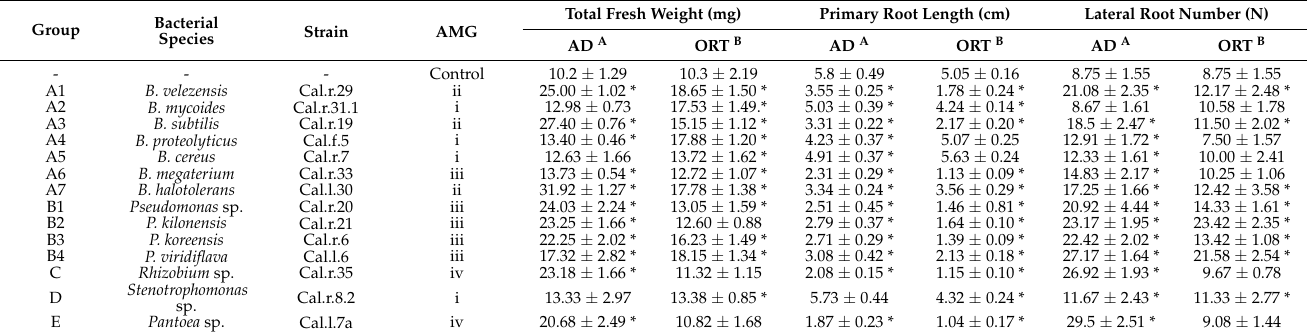
Table 1. Plant growth effect of representative endophytic bacterial strains of each bacterial species on different growth parameters of A. thaliana seedlings under in vitro formulation. Data values represent the mean of 12 seedlings ± SD per treatment. Asterisks indicate the statistical difference between control plants and plants after bacterial formulation.